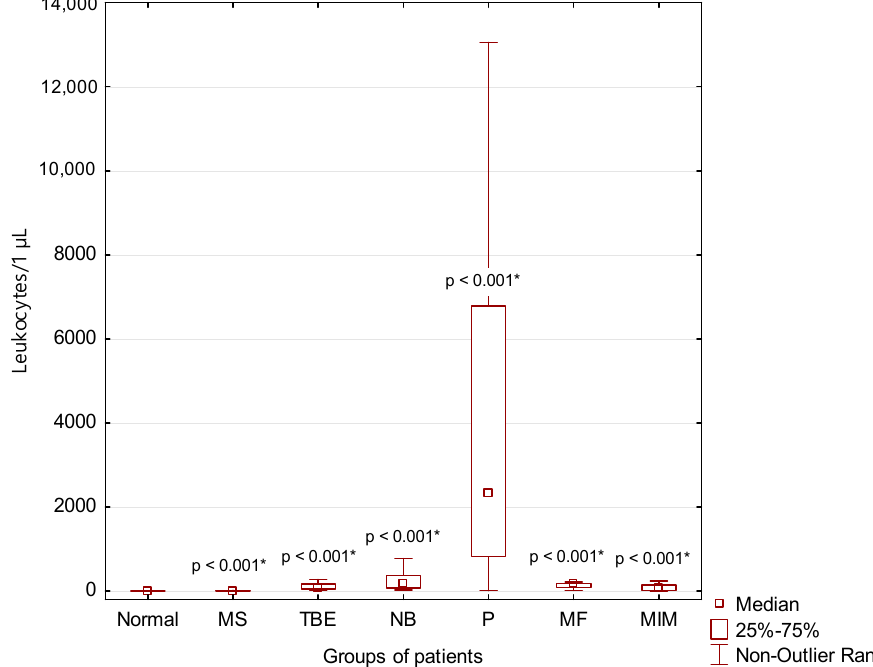
Figure 3. CSF leukocyte counts in our patient groups (*: statistically significant). A significantly higher percentage of lymphocytes in CSF compared to normal CSF findings was found in patients with MS ( p < 0.001) and NB ( p < 0.001), and a significantly lower percentage of lymphocytes was found in patients with purulent inflammation (P) in the CNS ( p < 0.001 *) (Figure 4).